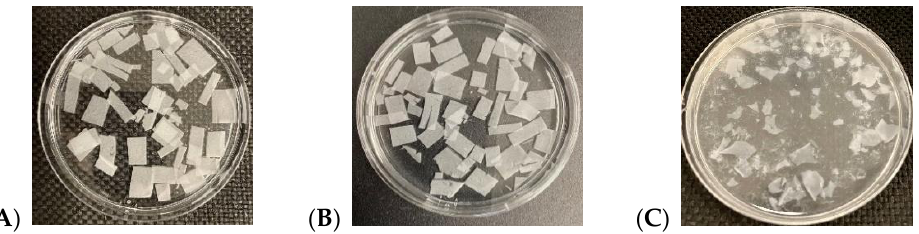
Figure 13. Biodegradability feature of the starch-based wound dressings: ( A ) 24 h; ( B ) 72 h; ( C ) Day 14.